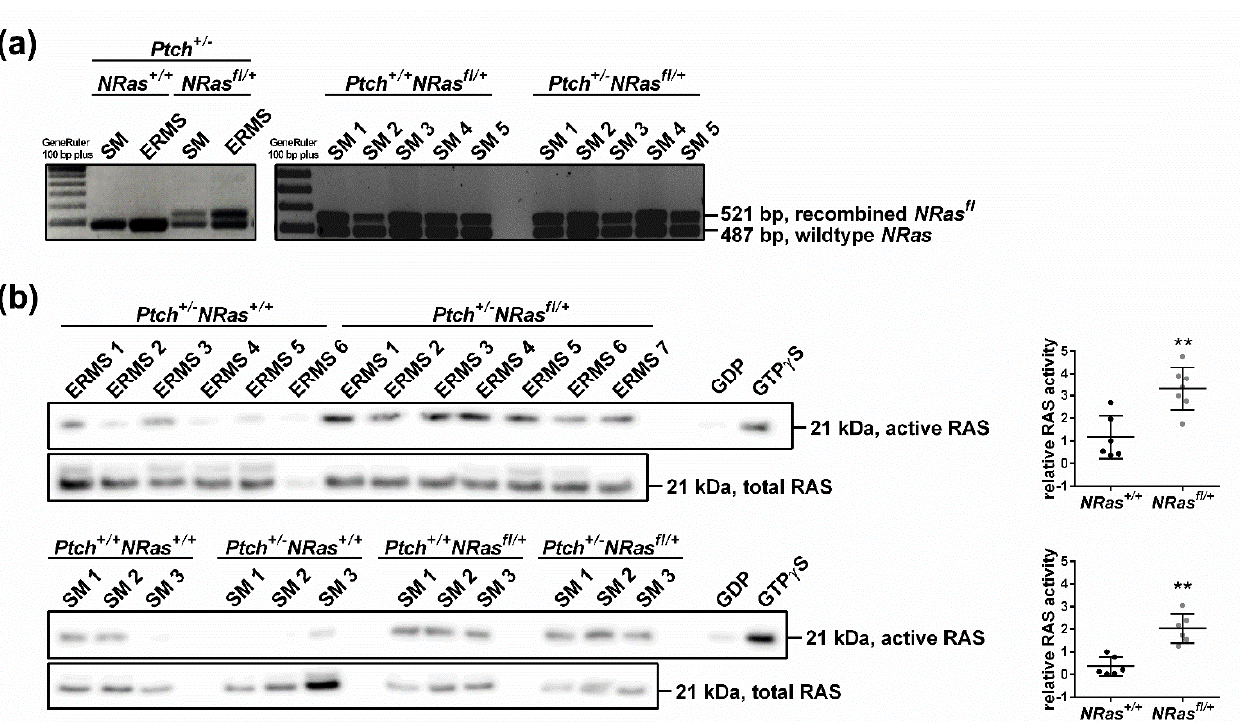
Figure 2. RAS activity in ERMS and normal skeletal muscle upon oncNRAS expression in 2-week-old mice. RAS activation in ERMS and skeletal muscle (SM) of Ptch +/- NRas +/+ Myf5 CreER/wt ( Ptch +/- NRas +/+ ), Ptch +/- NRas fl/+ Myf5 CreER/wt ( Ptch +/- NRas fl/+ ) or SM of Ptch +/+ NRas +/+ Myf5 CreER/wt ( Ptch +/+ NRas +/+ ) and Ptch +/+ NRas fl/+ Myf5 CreER/wt ( Ptch +/+ NRas fl/+ ) mice injected with tamoxifen at 2 weeks old. ( a ) PCR-based recombination analyses of the floxed NRas ( NRas fl ) locus on genomic DNA from SM and ERMS of Ptch +/- NRas +/+ and Ptch +/- NRas fl/+ mice (left) and from SM of Ptch +/+ NRas fl/+ and Ptch +/- NRas fl/+ mice (right). ( b ) RAS pull-down assays (left) and RAS activity quantification (right, active/total RAS) of ERMS protein samples isolated from Ptch +/- NRas fl/+ and Ptch +/- NRas fl/+ mice (top) and of SM protein samples isolated from Ptch +/+ NRas +/+ , Ptch +/- NRas +/+ , Ptch +/- NRas fl/+ and Ptch +/- NRas fl/+ mice (bottom). RAS pull-down of lysates incubated with GDP or the GTP analog GTP γ S served as negative or positive controls, respectively. (Please note that the used RAS antibody was not isoform-specific. However, because the floxed NRAS locus is very well recombined, it is more than likely that the increase in RAS activity is due to expression of oncNRAS and not to other RAS isoforms.) Bars: mean ± SD; dots: individual tumors. Statistical evaluation was conducted by Mann–Whitney testing. ** p < 0.01.